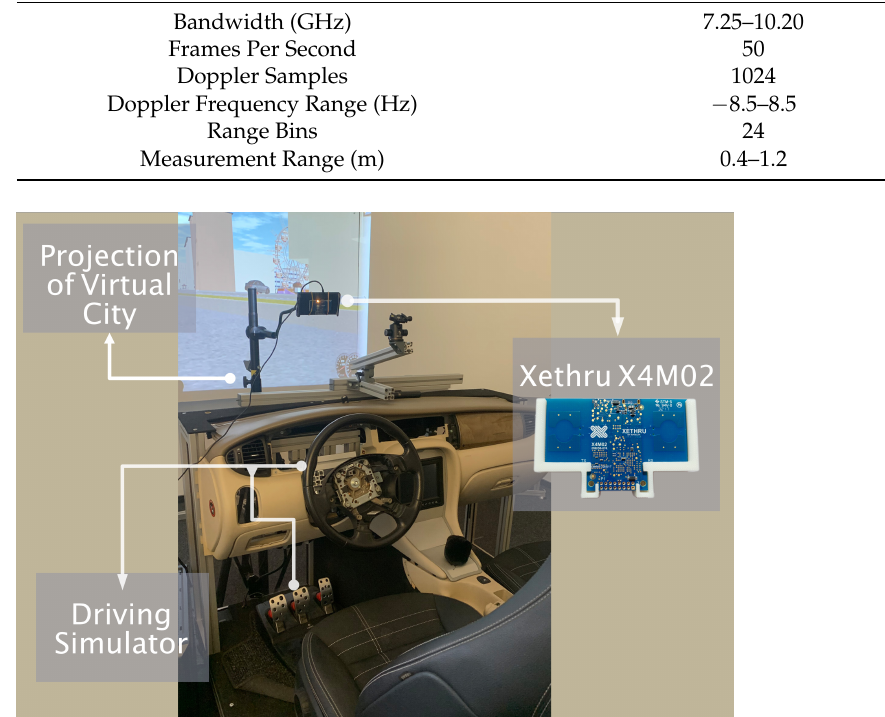
Figure 2. View of the driving simulator recording environment with the UWB Radar Xethru X4M02 in